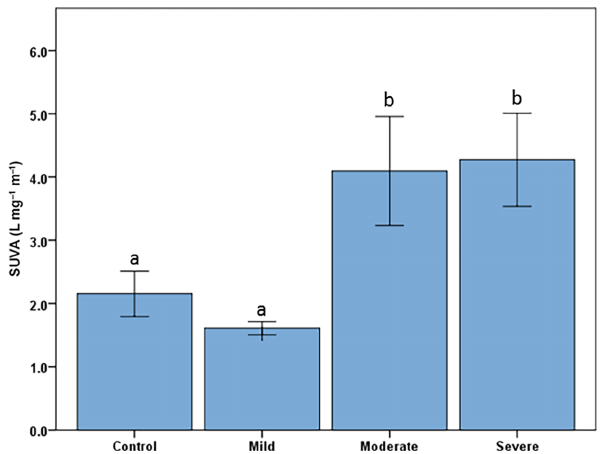
Figure 4. DOC removal efficiency by coagulation/flocculation for different DOC sources ( n = 20 for each source) with error bars at 1 standard error. Letters indicate statistical subset according to Tukey